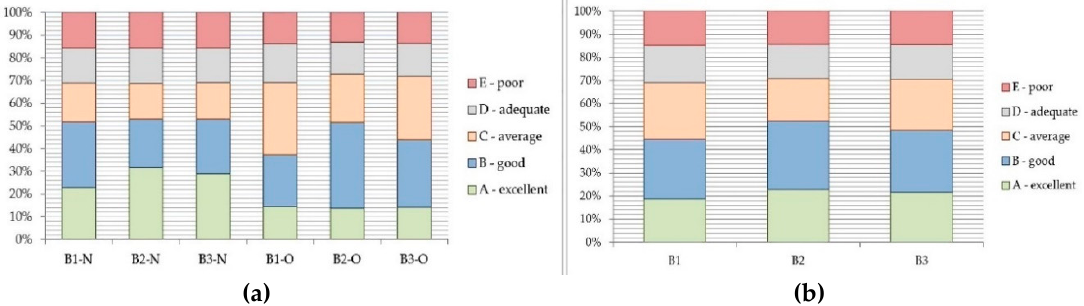
Figure 4. Comparative analysis of all bulldozers availability and analysis according to different models. ( a ) for all of the analysed machines; ( b ) for machines according to manufacturer.